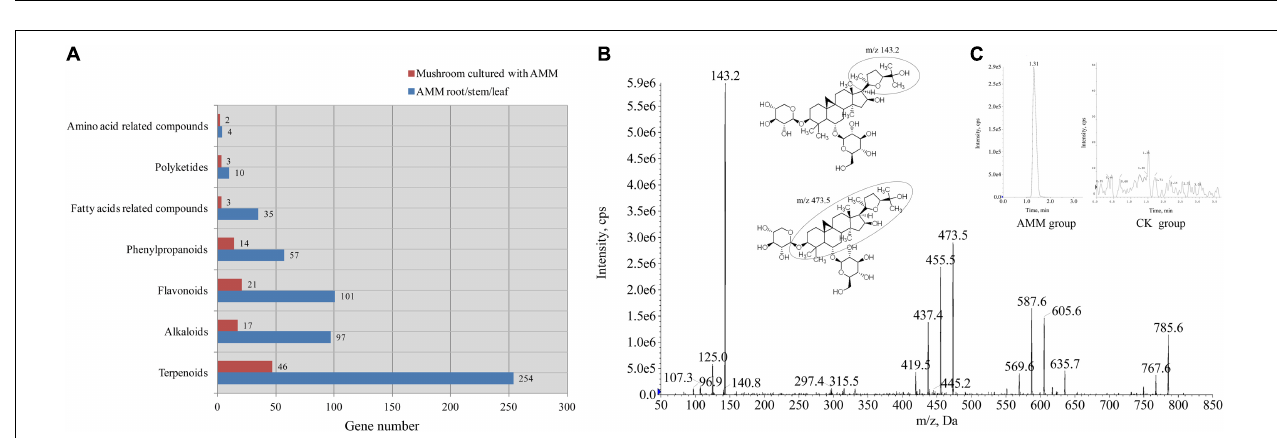
FIGURE 3 | Functional classification and annotation of differential metabolites identified in the comparison between AMM and control group. (A) The KEGG classification of differential metabolites; (B) KEGG pathway enrichment of differential metabolites.